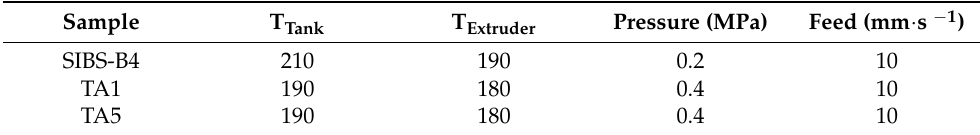
Table 2. FDM printing parameters of polymer SIBS-B4, containing 1 wt % (TA1) and 5 wt % (TA5) of triamcinolone acetonide (TA), respectively.